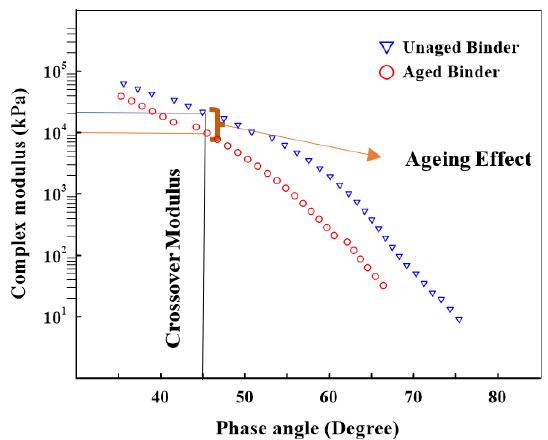
Figure 10. Evaluating the aging influence on the crossover modulus.